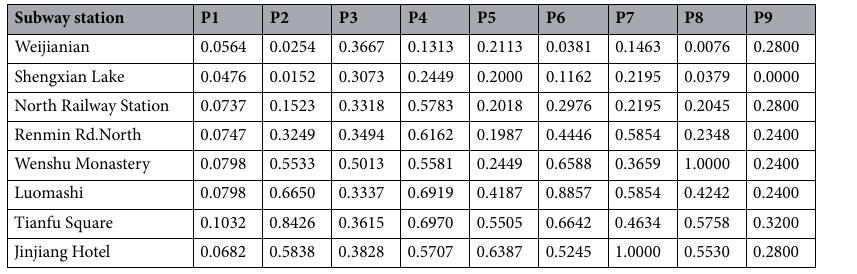
Table 5. The values of place indicators in each subway station normalized by Min–Max Normalization